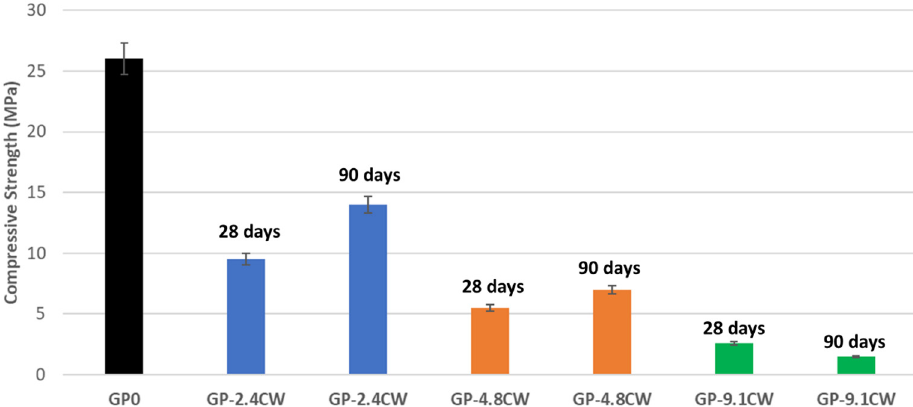
Figure 8. Compressive strength for all the samples after 28 and 90 days.